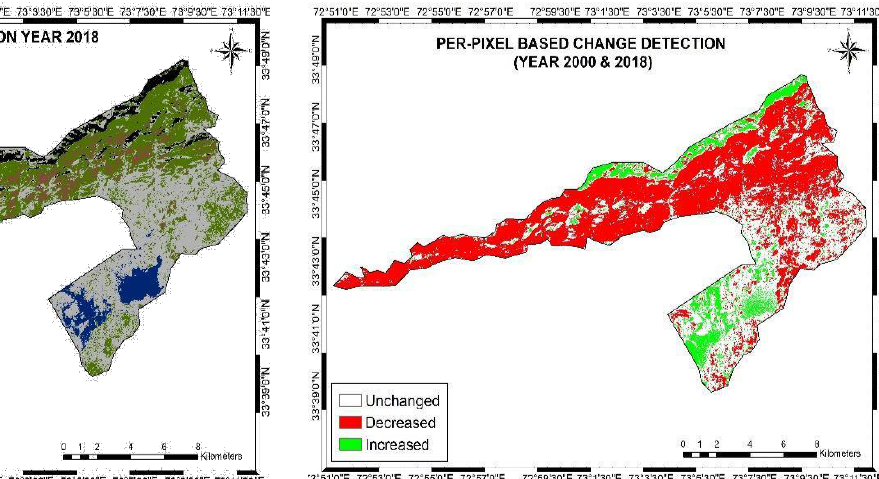
Figure 3: Land Use/ Land Cover Supervised Classification Margalla Hills National Park (MHNP) Year 2018 Islamabad, Pakistan.